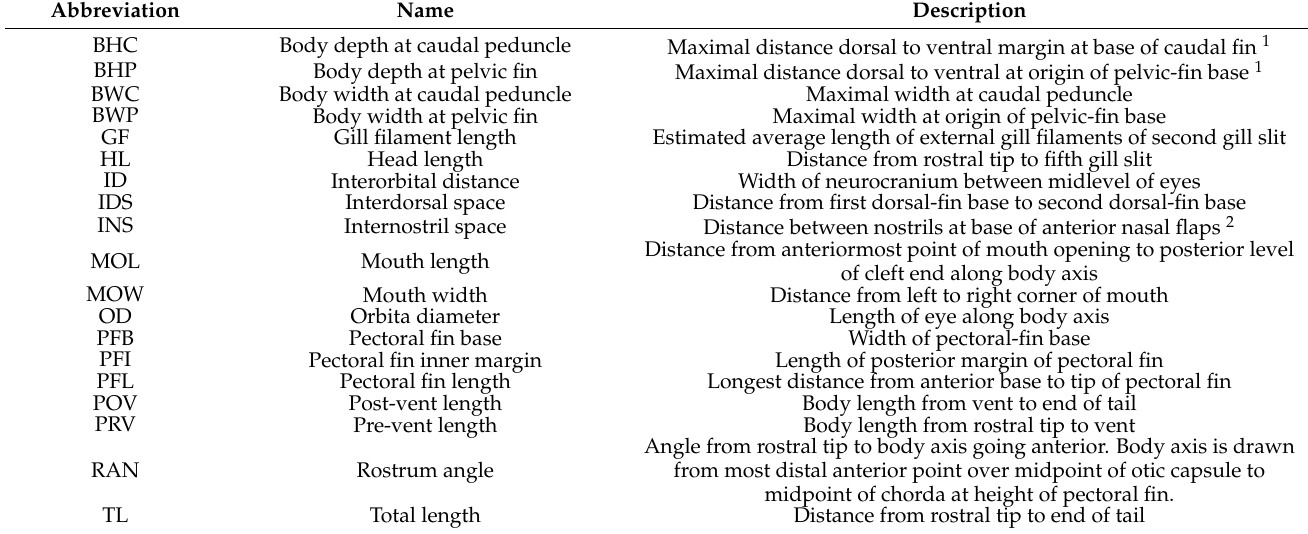
Table 1. Morphological parameters with their used abbreviations and description.